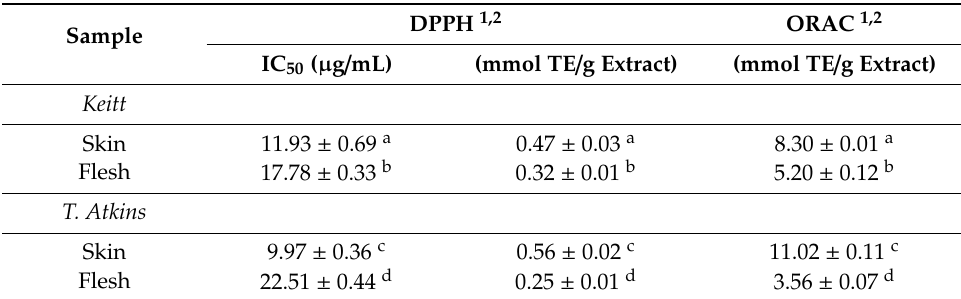
Table 3. DPPH and ORAC antioxidant activity.